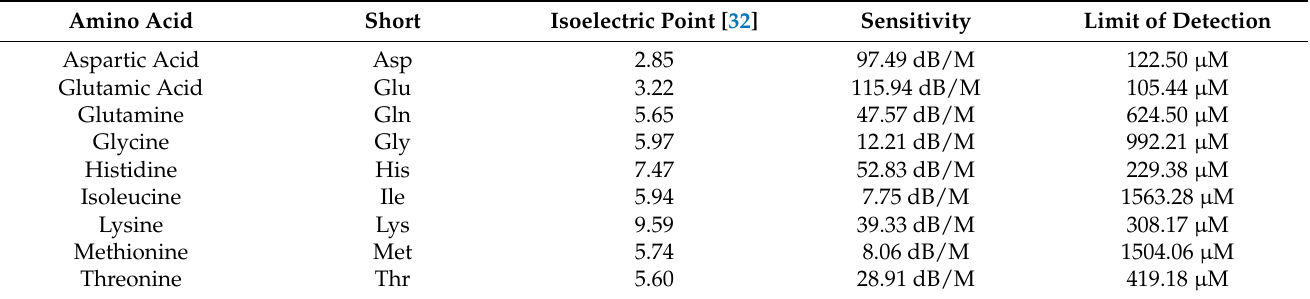
Table 3. Isoelectric points, sensitivities and limits of detection for nine amino acids in UHPLC-MS grade water when measuring the attenuation at the resonance frequency for UHPLC-MS grade water as a measure for amino acid